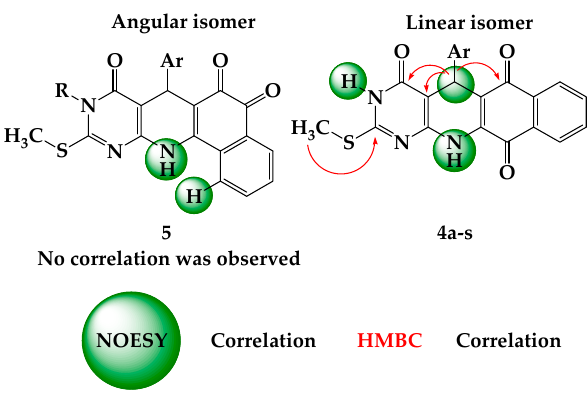
Figure 1. The NOESY (Nuclear Overhauser Effect Spectroscopy) experiment showed no correlation between NH-aromatic hydrogen. HMBC (Heteronuclear Multiple Bond Correlation) spectrum shows correlations between SCH 3 /C2, C(5)H/C4, C(5)H/C4a and C(5)H/C7.